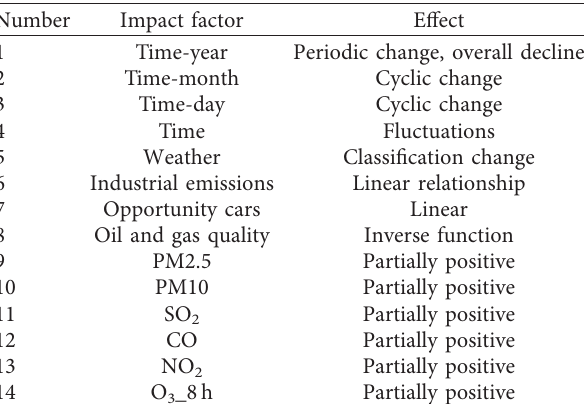
Table 1: Impact factors of air